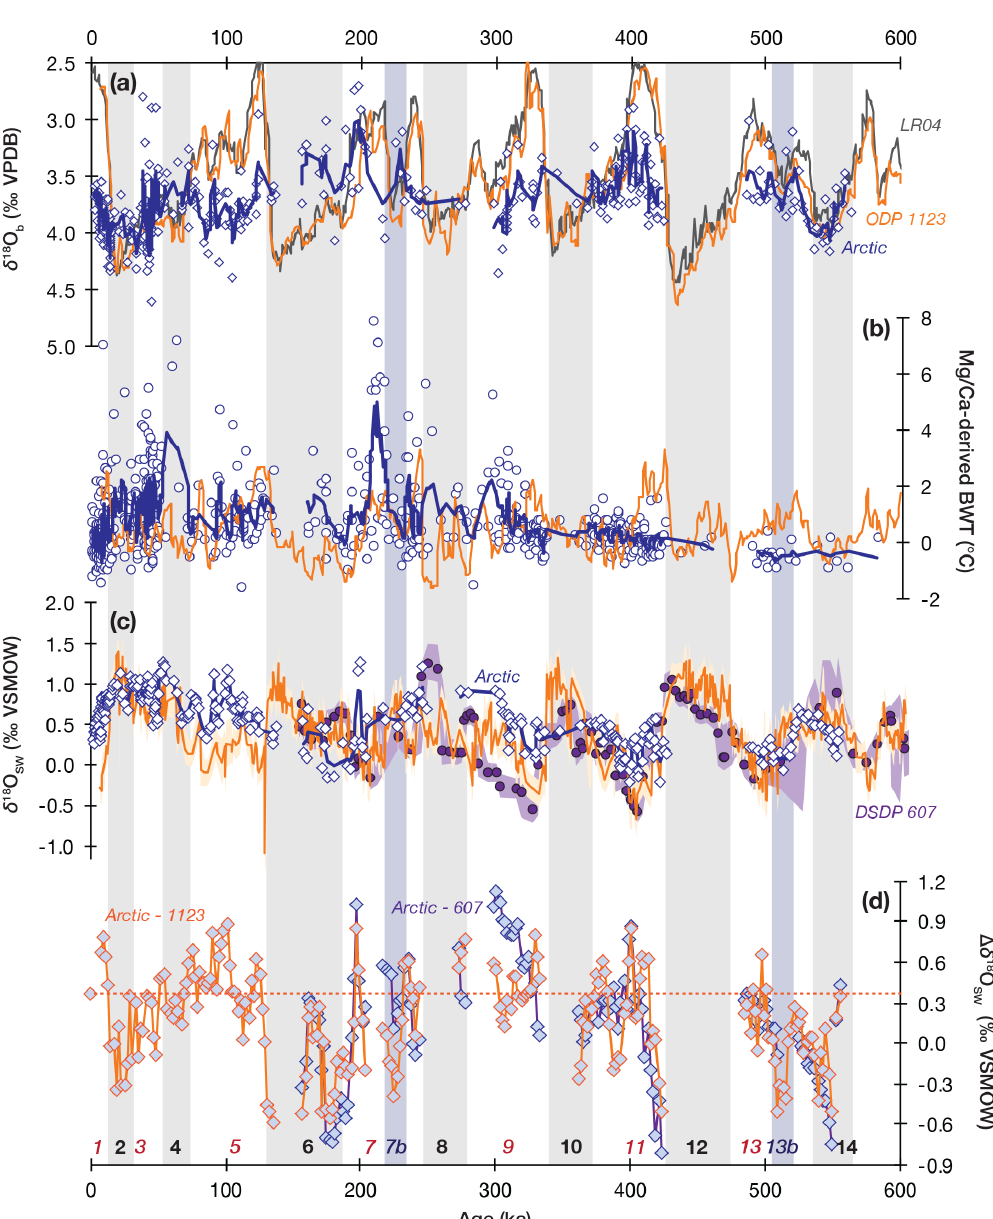
Figure 4. (a) Individual sample Arctic δ 18 O b (blue diamonds) and three-point running mean (blue line) compared to interpolated ODP Site 1123 (orange line; Elderfield et al., 2010, 2012) and global ocean LR04 stack (gray line; Lisiecki and Raymo, 2005). (b) Reconstructed bottom-water temperatures from Arctic ostracode Mg / Ca (blue circles) and five-point running mean (blue line; Cronin et al., 2012, 2017) and Site 1123 benthic foraminiferal Mg / Ca (orange line). (c) δ 18 O sw reconstructed from the Arctic (blue diamonds are discrete data points; blue line is three-point running mean), Site 1123 (orange line; shading is 1SD propagated error; data from Elderfield et al., 2012, and recalculated by Ford and Raymo, 2020), and Site 607 (purple circles; shading is 1SD propagated error; Ford and Raymo, 2020). (d) (cid:49)δ 18 O sw (Arctic – 1123 in orange; Arctic – 607 in blue) as a proxy for local Arctic δ 18 O sw change. The modern (cid:49)δ 18 O sw between the Arctic and Site 1123 is indicated by the dashed orange line. Gaps in the Arctic record illustrate intervals with limited microfossil abundance. Interglacial marine isotope stages are numbered red; glacial marine isotope stages are shaded gray and numbered; interglacial substages 7b and 13b are shaded